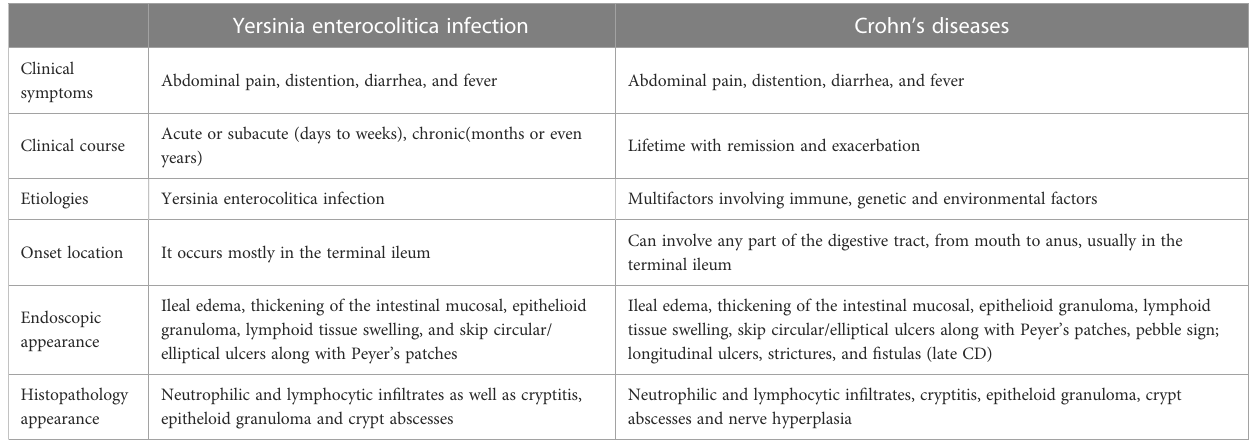
TABLE 2 Clinical symptoms and pathological manifestations of CD and Y. enterocolitica